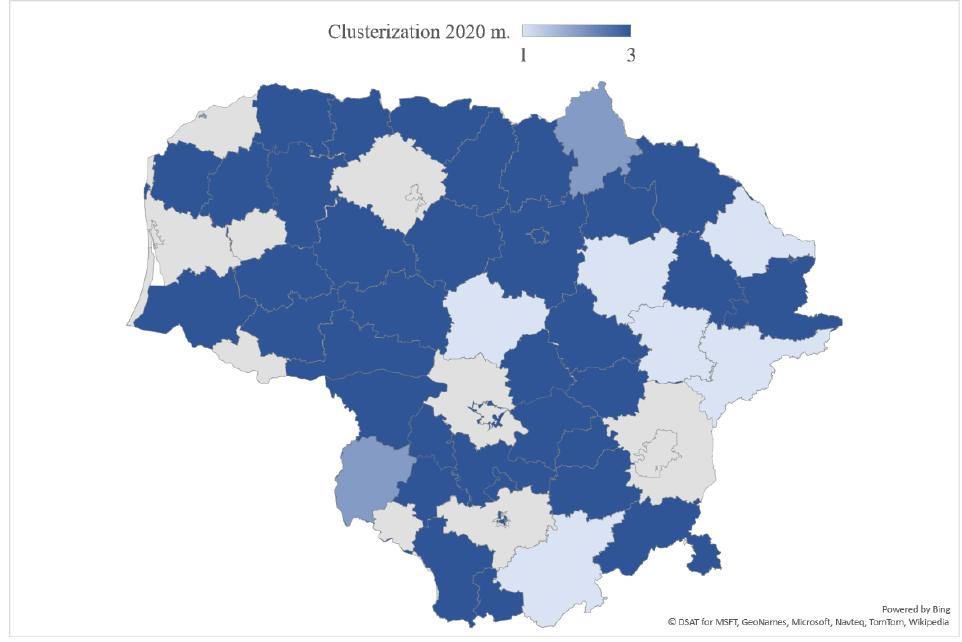
Figure 3. The results of clustering applying clusters analysis of 2020.